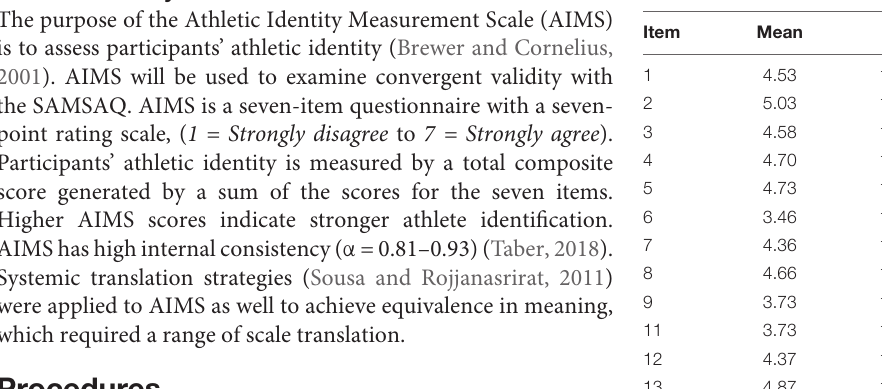
TABLE 1 | Mean and standard deviation values for SAMSAQ items ( N =